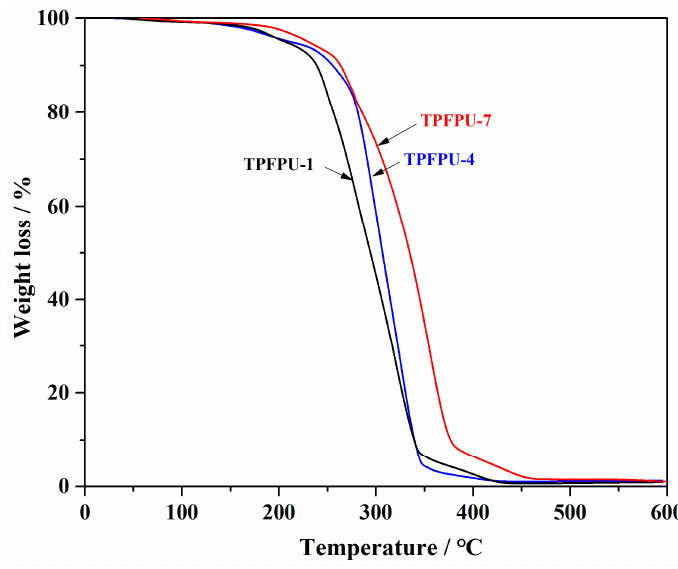
Figure 6. TGA curves of the TPFLUs.